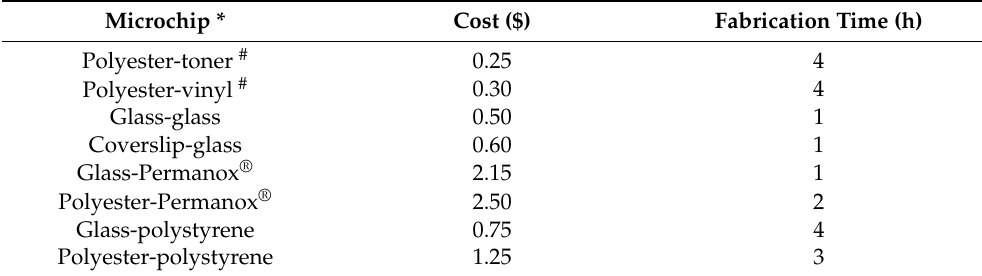
Table 1. Comparative analyses for the cost of materials and the time for fabrication for each type of microchip produced at the laboratory scale